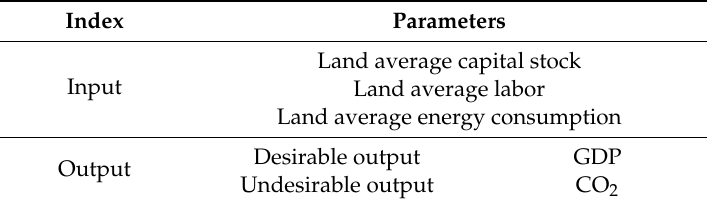
Table 1. Summary of input and output